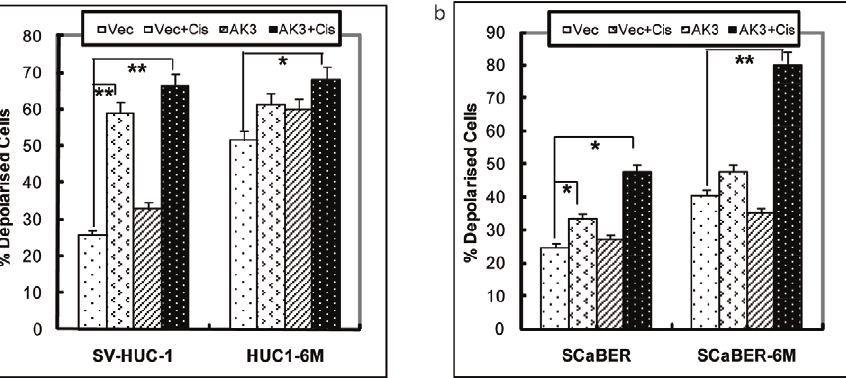
Figure 2. DY m Alteration by AK3 in the Presence of Cisplatin. Mitochondrial membrane potential was measured in SV-HUC1, HUC1-6M (a), SCaBER and SCaBER-6M (b) cells transfected with AK3 or control vector, followed by treatment with cisplatin for 48 h. Cells were stained with JC-1 reagent and cell fluorescence was measured on a flow cytometer using Fl1 and Fl2 channels. Increase of red fluorescence indicates hyper-polarization of mitochondrial membrane potential (A¨ Y m). * indicates P , 0.05 and ** indicates P , 0.01.